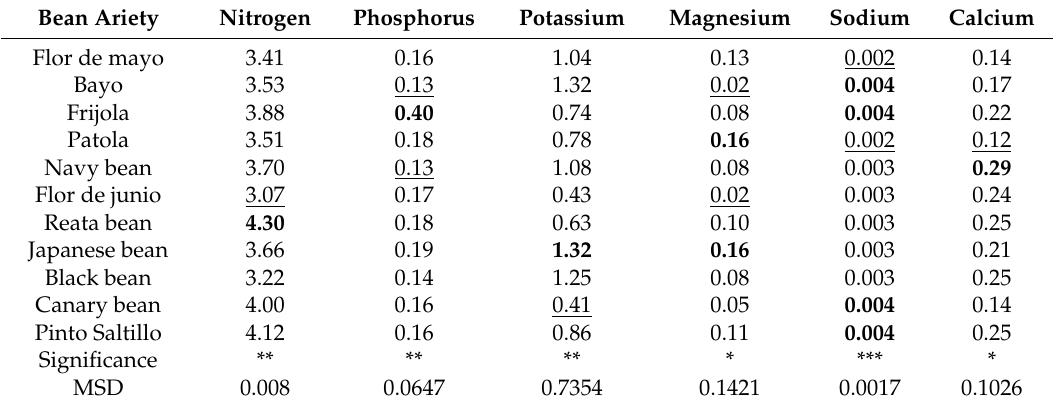
Table 6. Concentration of macronutrients (%) found in bean varieties grown and consumed in the state of Zacatecas,